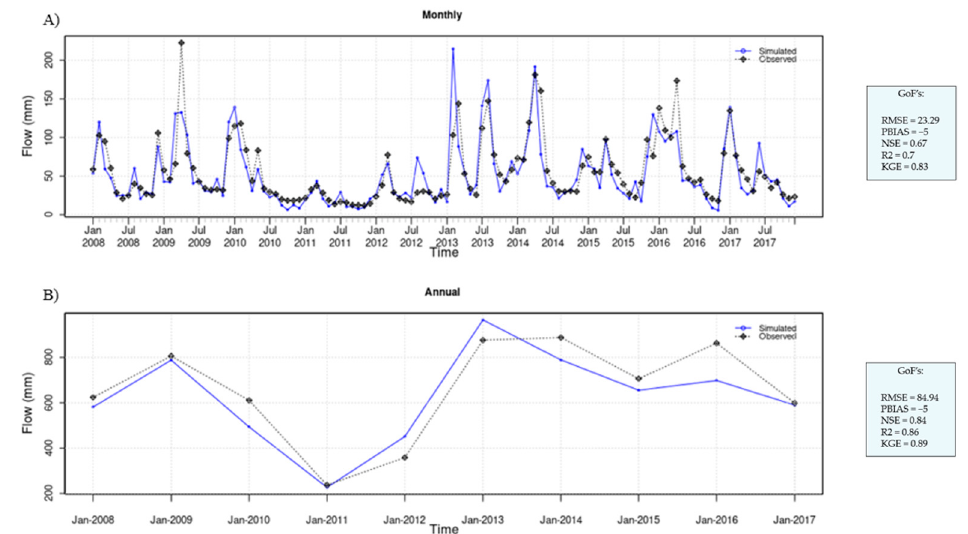
Figure 10. The WaSSI model validation with ( A ) monthly and ( B ) annual measured streamflow at the USGS gauging station Chipola River near Altha, FL, USA, ID No. 02359000. Consistent with the DMC method, the WaSSI scenario run did not detect significant increases in streamflow during 2019 and 2020 ( p > 0.05). At the annual scale, LAI change from vegetation damage on streamflow was small, resulting in 12 mm (2.6%) and 7.3 mm (1.0%) increases in inflow in 2019 and 2020. However, the effects of LAI decline were much stronger on the monthly scale in 2019, which led to a more than 5% increase in flow during August and September of 2019 (Figure 11).